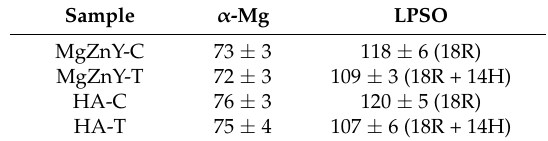
Table 3. Vickers hardness (HV) of the the α -Mg and LPSO phases in the tested alloys.